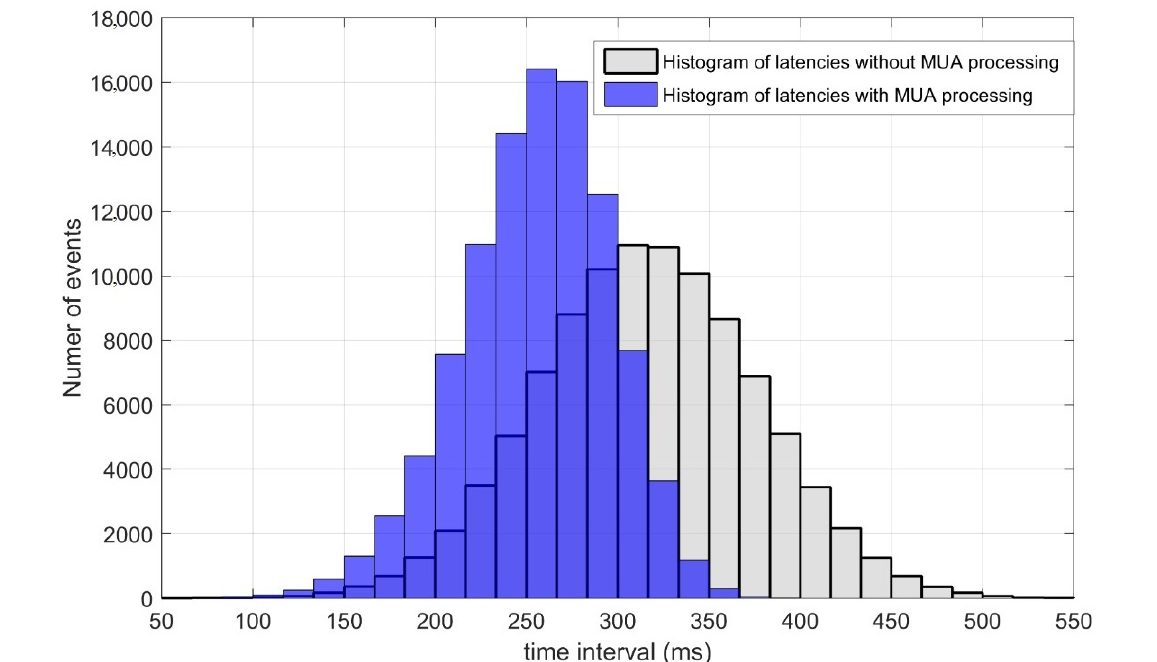
Figure 4. Time Delay shape after using enhanced time delay compensator (ETDC) compared with Sliding Prediction Block